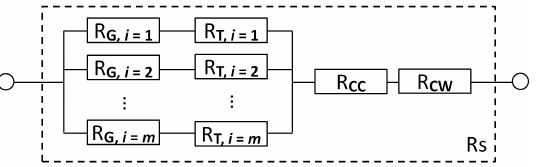
Figure 10. Idealized circuit diagram for the approximation of the electrical resistance of a contacted specimen, consisting of aluminum fibers in the gauge length ( R G ) and the end tabs ( R T ), and additional resistances for the crimping connections ( R CC ) and the copper wire ( R CW